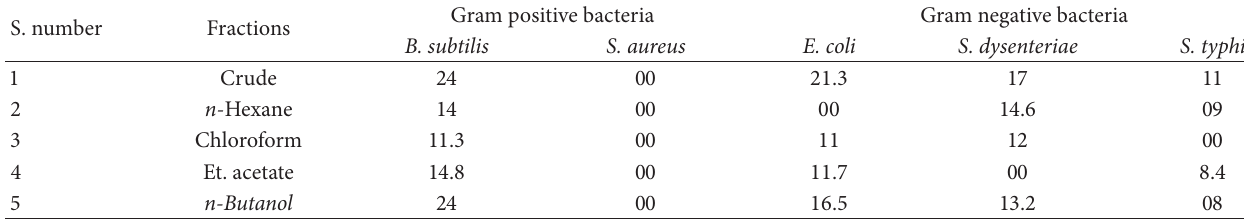
Table 1: Showing zones of inhibition (mm) against different bacteria.